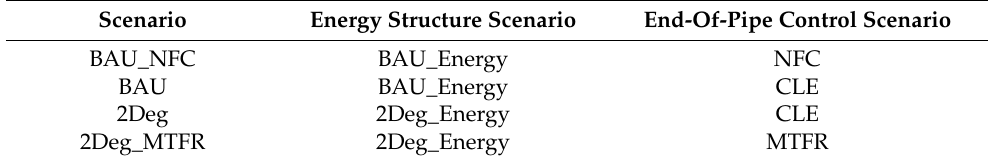
Table 1. Scenario design of the